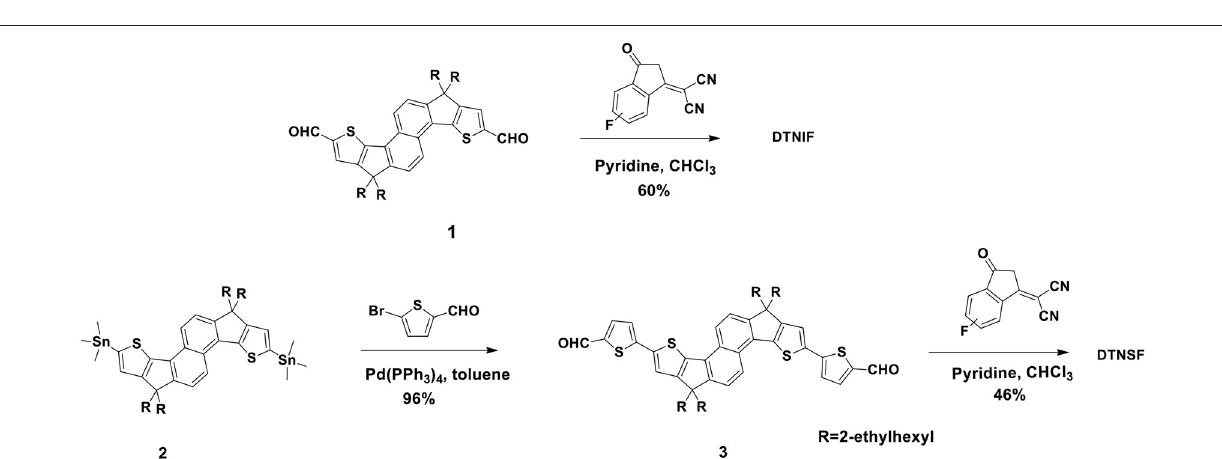
SCHEME 1 | Synthetic routes of the non-fullerene acceptors.